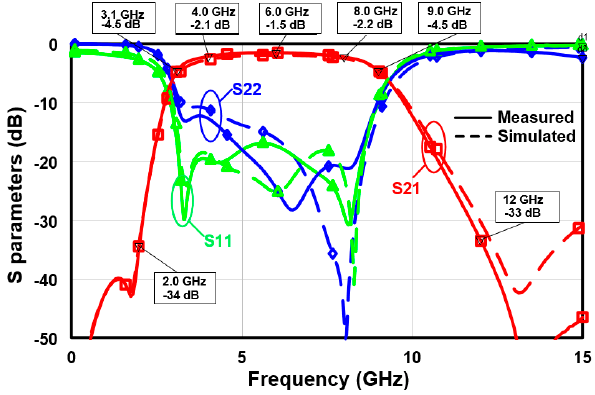
Figure 11. Measured and simulated S parameters of the proposed filter.